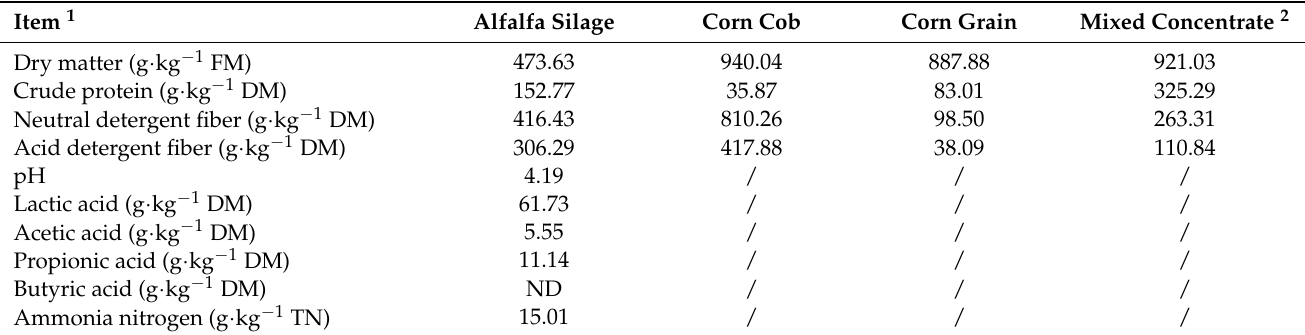
Table 1. Chemical composition and fermentation characteristics of ingredients used for the total mixed ration.